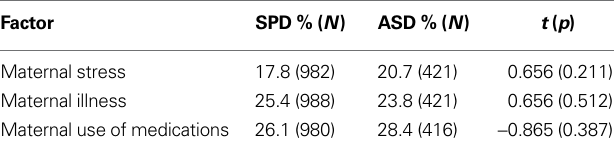
Table 3 | Percentage, valid N , and T -tests of pre-natal/pregnancy factors for SPD and ASD